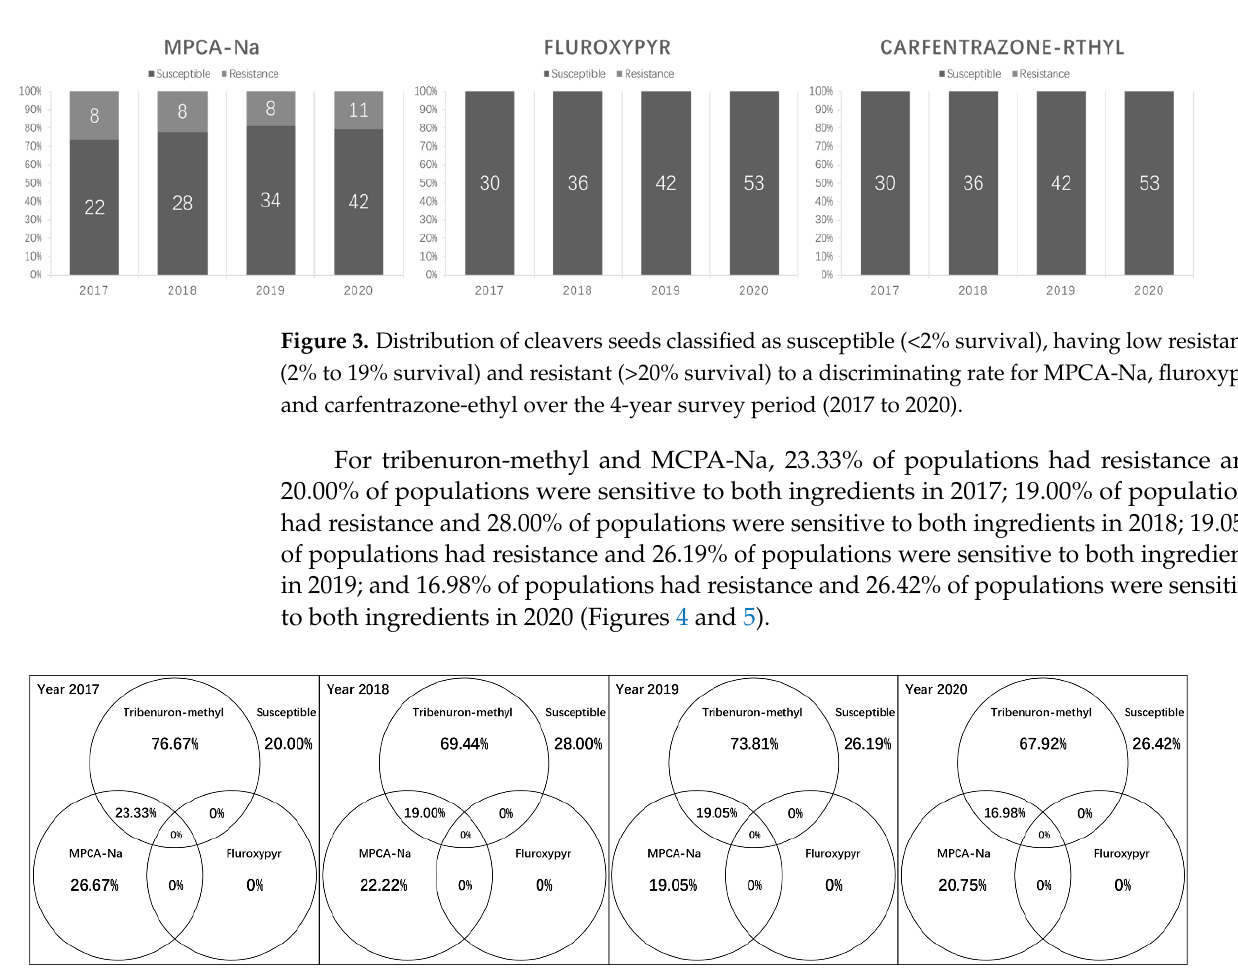
Figure 4. Proportion of cleavers seeds characterized as resistant (>20% survival) or having low resistance (2% to 19% survival) to tribenuron-methyl and two auxin herbicides (MPCA-Na and Fluroxypyr), and the proportion of seeds that were completely susceptible (<2% survival) to all three